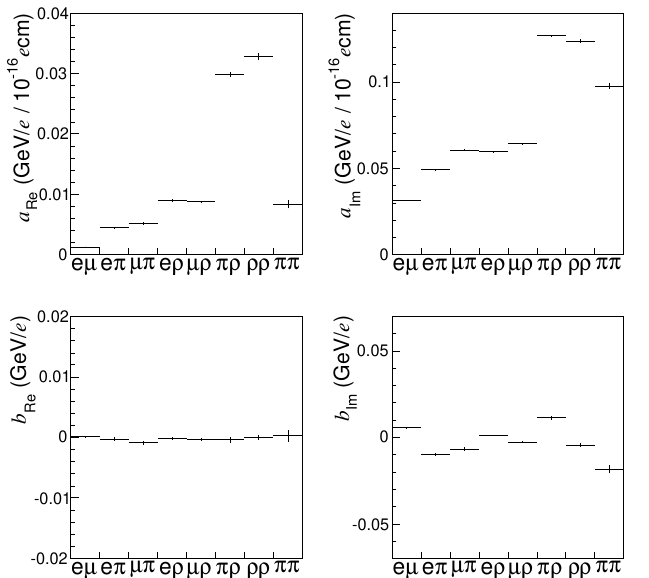
Figure 5 . EDM parameter sensitivity a uncertainties are due to the statistics of the MC